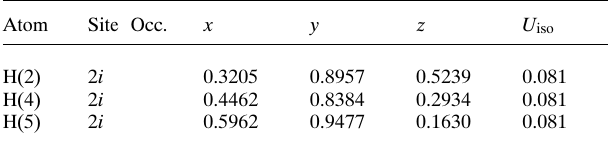
Table 5. Atomic coordinates and displacement parameters (in Å 2 )